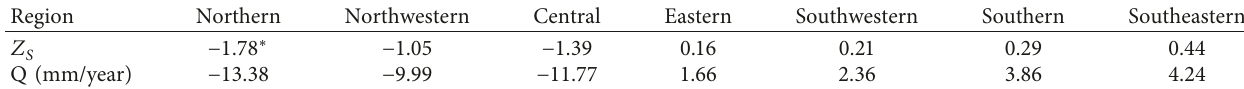
Table 2: Trend analysis in difference regions of